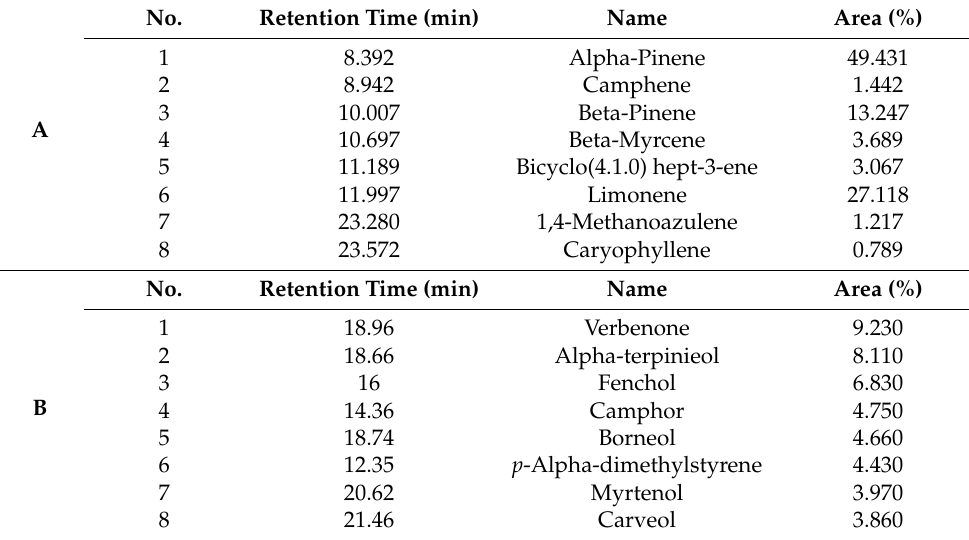
Table 2. Composition of phytoncide in ( A ) oil phase (PO) and in the ( B ) water phase (PW) through GC-MS